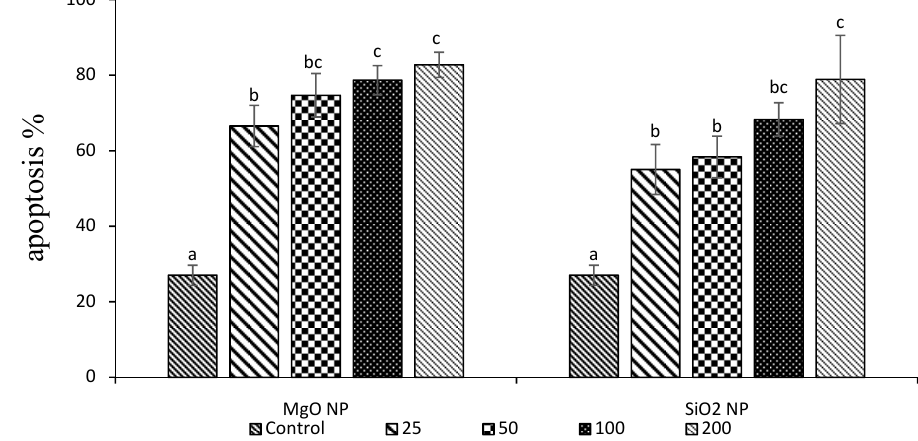
Fig. 4. The effect of different concentrations of MgO and SiO 2 NPs on HT-29 cells apoptosis after 24 hours of exposure (with fluorescence staining). Different letters show the significant difference between groups (P<0.05).